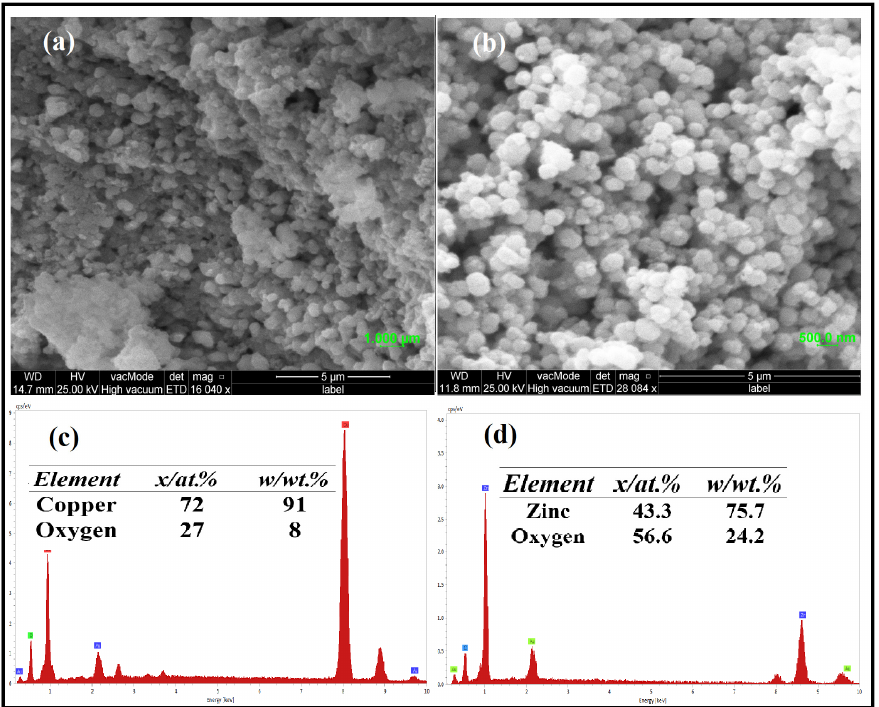
Figure 5. ( a , b ) FE-SEM images of CuO and ZnO NPS; ( c , d ) EDX spectra of CuO and ZnO NPs.